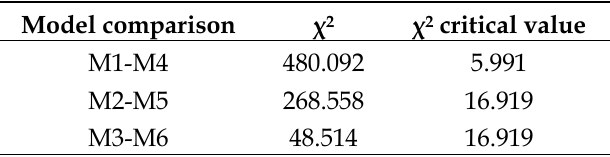
Table 3. Log-likelihood ratio